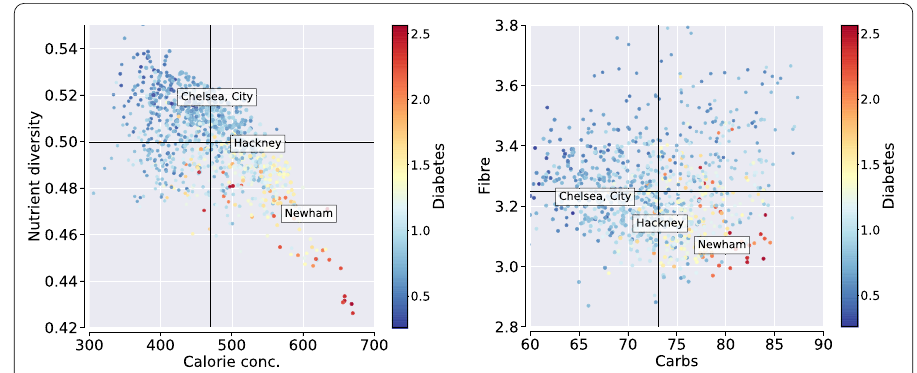
Figure 6 Two quadrants that place areas (MSOAs) according to their values for food-related predictor pairs (computed with Formulae (3), (4), and (5)), and that colors them according to per-capita prevalence of diabetes (computed with Formula (1)). The horizontal and vertical black lines represent the median values. Healthy areas are at the top-left quadrant, while unhealthy ones are at the bottom-right quadrant